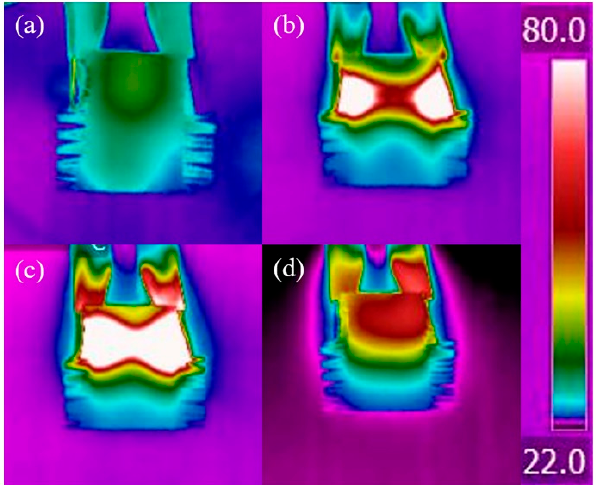
Figure 7. Temperature distribution of CFF-G/SPU composite: ( a ) without electricity; ( b ) under electric field for 10 s; ( c ) power off for 30 s; and ( d ) 60 s.